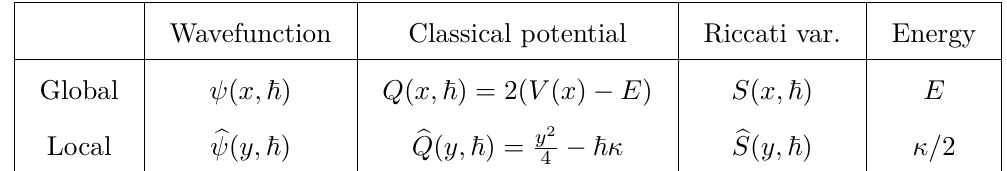
Table 2 . Notation table for global and local